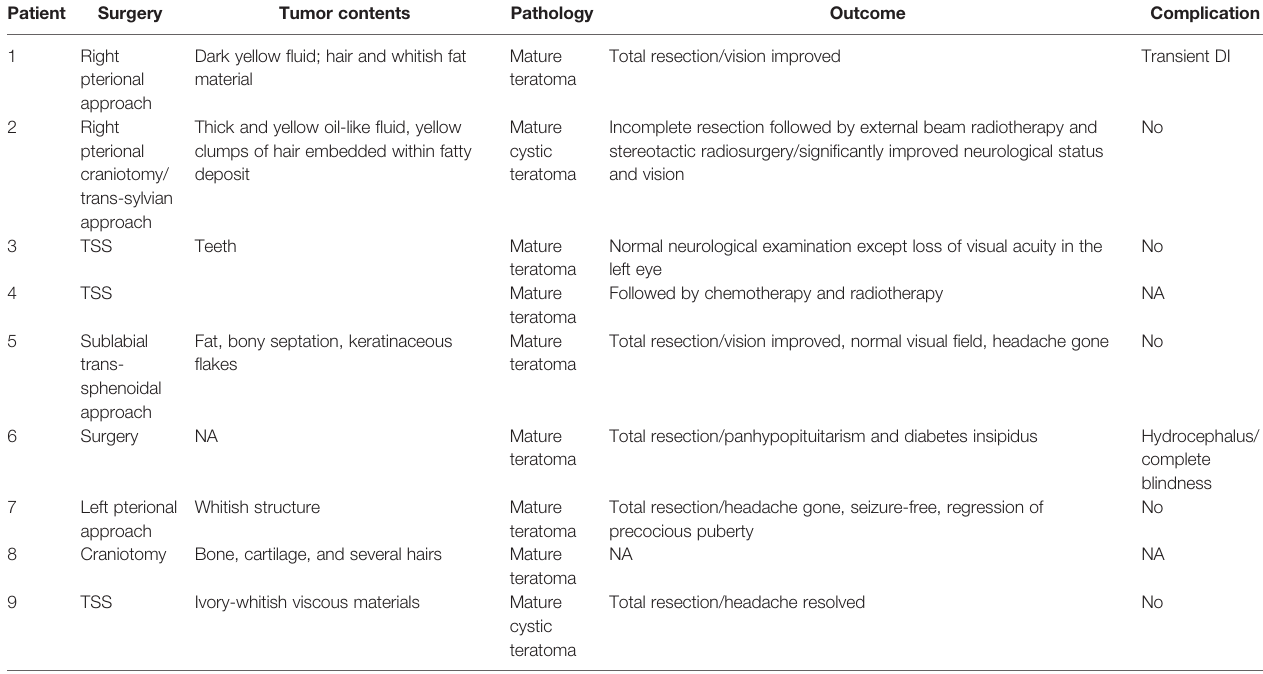
TABLE 4 | Treatment and outcome of patients from published